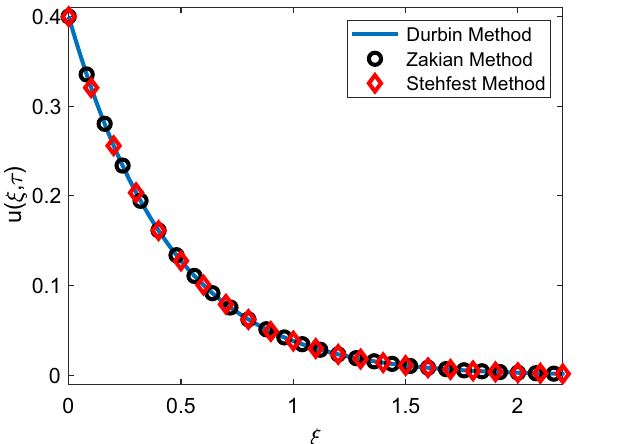
Figure 3. Validation of velocity